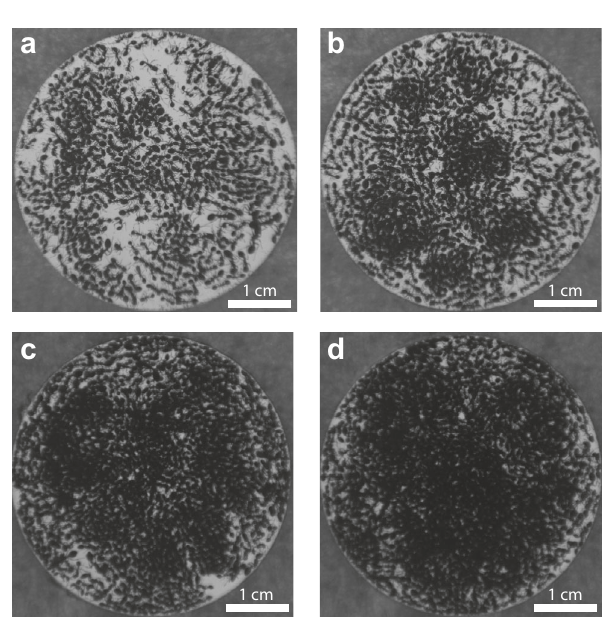
Fig.8|Effectsofincreasingdensity.a – d Framesfromexperimentsusing N =438, 625, 850, and 1012 ants, respectively. Notice that both the clusters and the back- ground of moving ants become denser when the number of ants in the cell